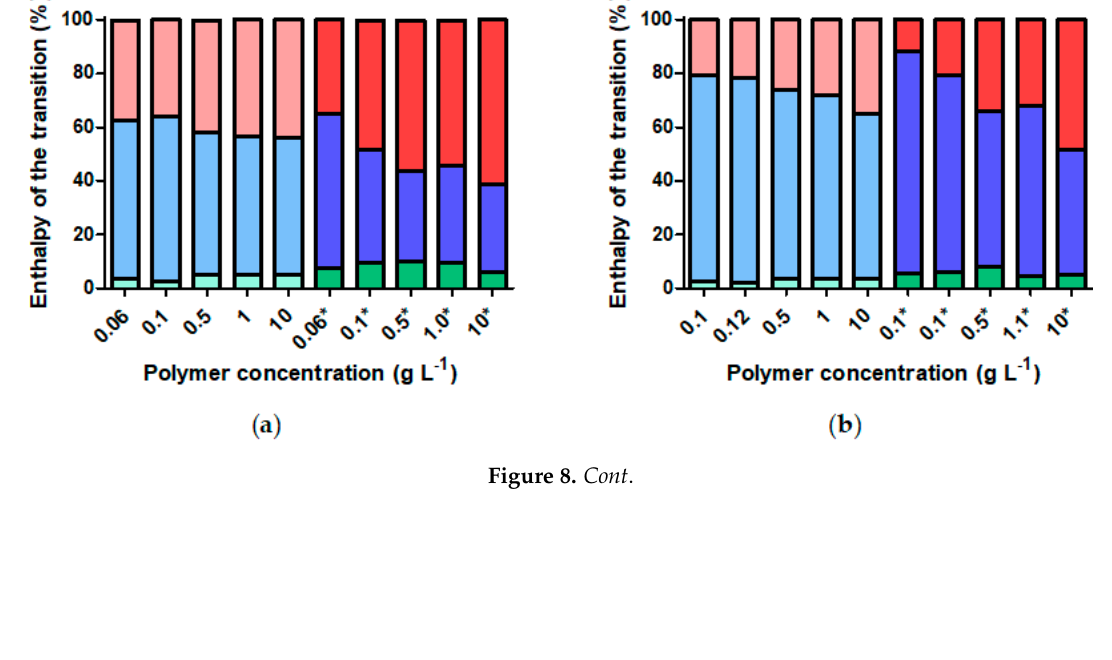
Figure 8. Fraction of the total transition enthalpy of each fitted transition peak for core-shell nanoparticles. All DSC curves were fitted with three Gaussian curves. The enthalpy of each fitted Gaussian was normalized by the total enthalpy of the transition to obtain the plotted fractions. Contributions of the lowest (red), intermediate (blue) and highest (green) temperature transitions were assigned to the inner, intermediate and outer shell, respectively. The cooling curves are marked with *. ( a ) FeOx-5; ( b ) FeOx-7; ( c ) FeOx-10; ( d ) FeOx-21. 4. Conclusions We have, for the first time, presented a comprehensive study on the thermoresponsiveness of iron oxide core-shell nanoparticles grafted with poly(2-isopropyl-2-oxazoline) as function of core size. Four different and highly monodisperse spherical cores were used, with average diameters of 5.1, 7.4, 10.2 and 20.9 nm, respectively. All particles showed excellent dispersibility and colloidal stability in water at room temperature, using 26 kg mol − 1 nitrodopamide-poly(2-isopropyl-2- oxazoline) densely grafted at ∼ 1.2 chains nm − 1 . Using DLS, we determined that changing the core size had little impact on the CFT of the nanoparticles, but there is a major difference in CFT of 4 ° C (at 1 g L − 1 polymer) between polymer brush stabilized nanoparticles and the corresponding free polymer. Particle core size, did not seem to influence cluster size during aggregation.